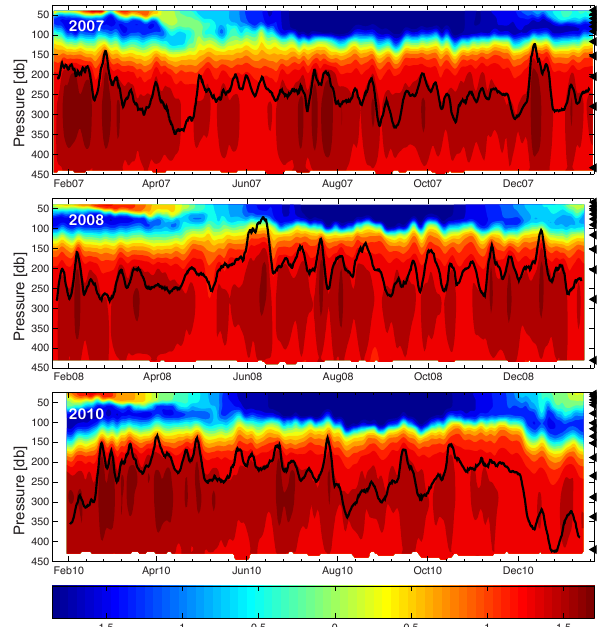
Fig. 5. For the mooring #1, T as a function of depth and time, with Q -series overlain (black line) to show the relationship between T and Q -events. Q -events clearly coincide with warm (red) deep an- ticyclonic boluses. Arrows on right ordinate show depths of T sen- sors. Color bar shows temperature